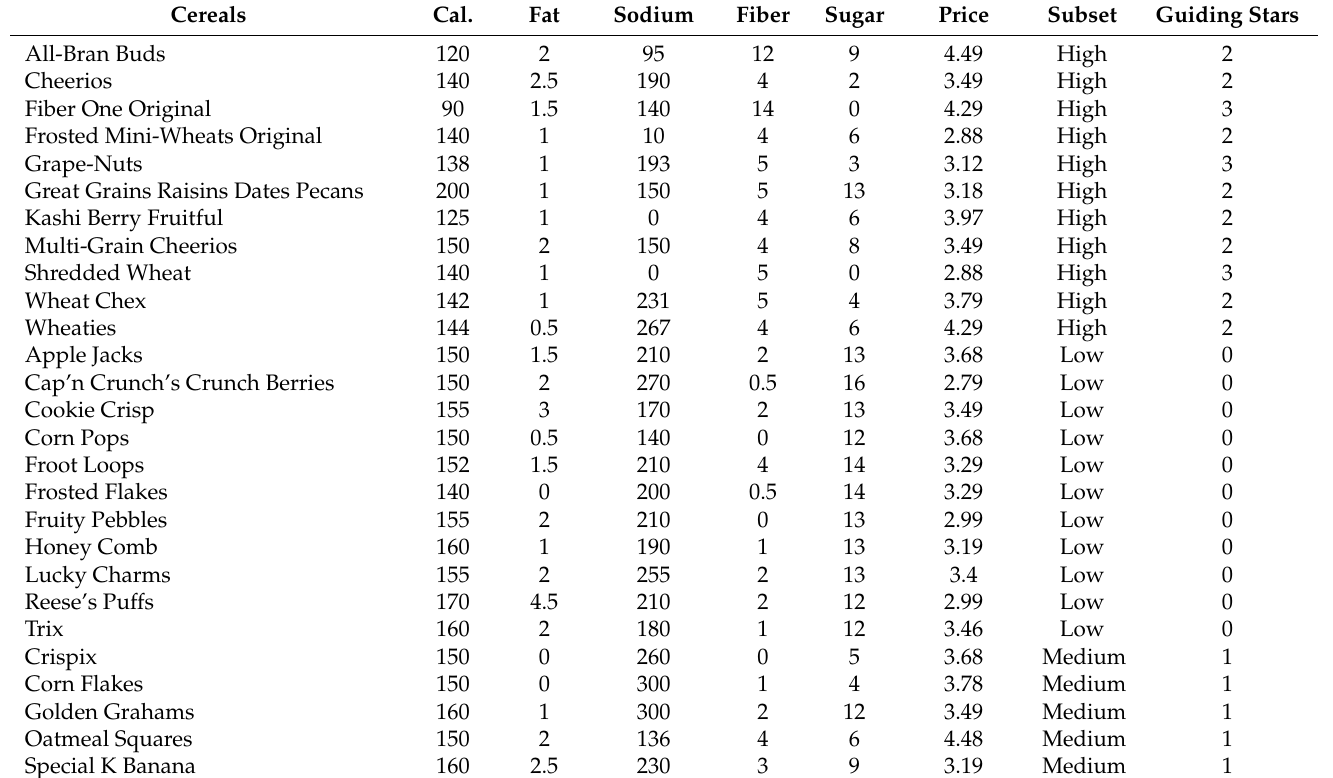
Table A2. Cereal products, nutritional and price information, and subsets in the